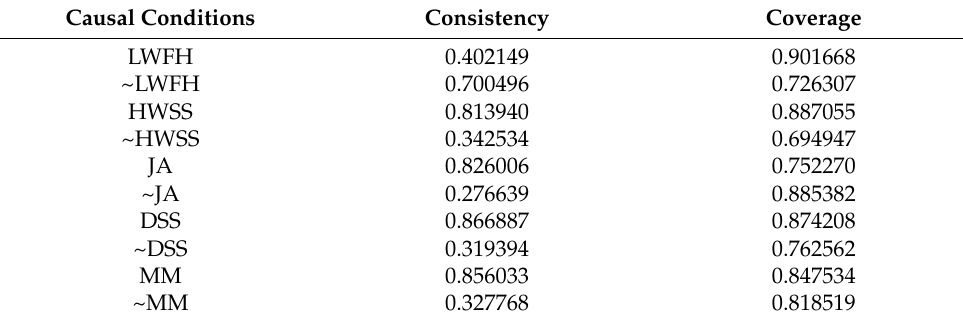
Table 3. Analysis of necessary